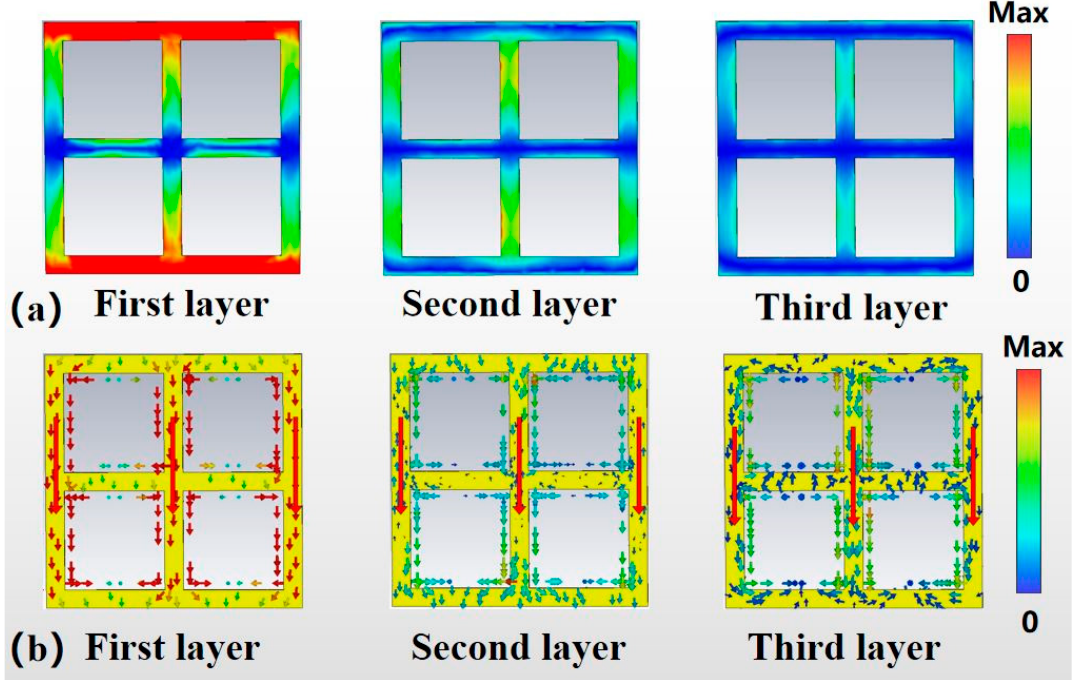
Figure 8: ( a ) electric field diagram at f = 1.08 THz; and ( b ) Current diagram at f = 1.08 THz.